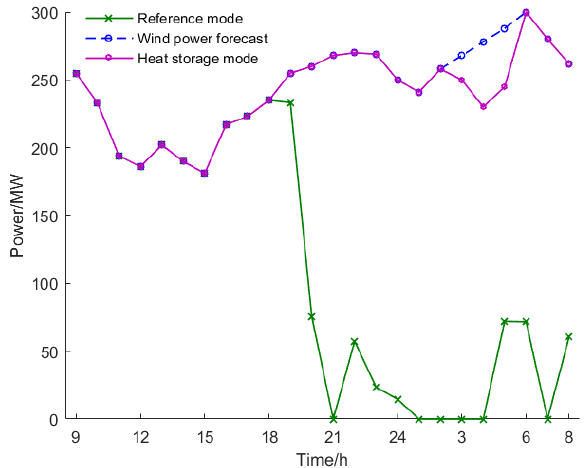
Figure 18. Wind power output.